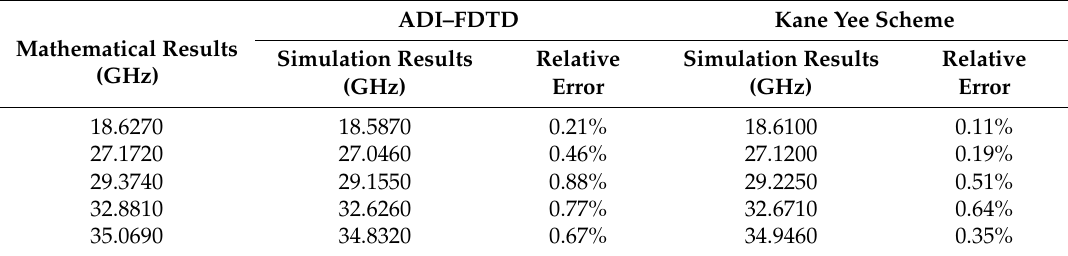
Table 2. Comparison of the inhomogeneous waveguide results of the Yee scheme and ADI-FDTD.